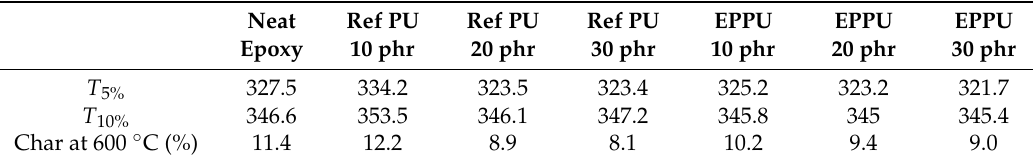
Table 5. Thermogravimetric analysis data at T 5% and T 10% and remaining contents.